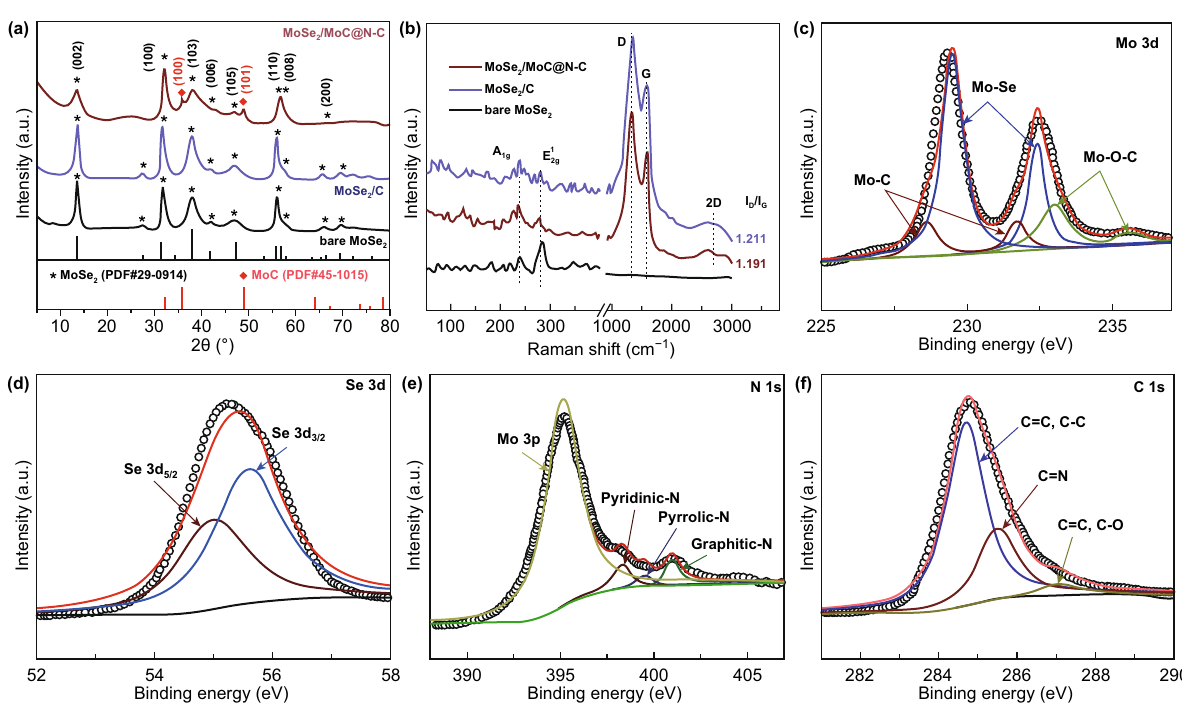
Fig. 1 a XRD patterns and b Raman spectrum of bare MoSe 2 , MoSe 2 /C, and MoSe 2 /MoC/N–C; XPS spectra of MoSe 2 /MoC/N–C: c Mo 3d, d Se 3d, e N 1 s, and f C 1